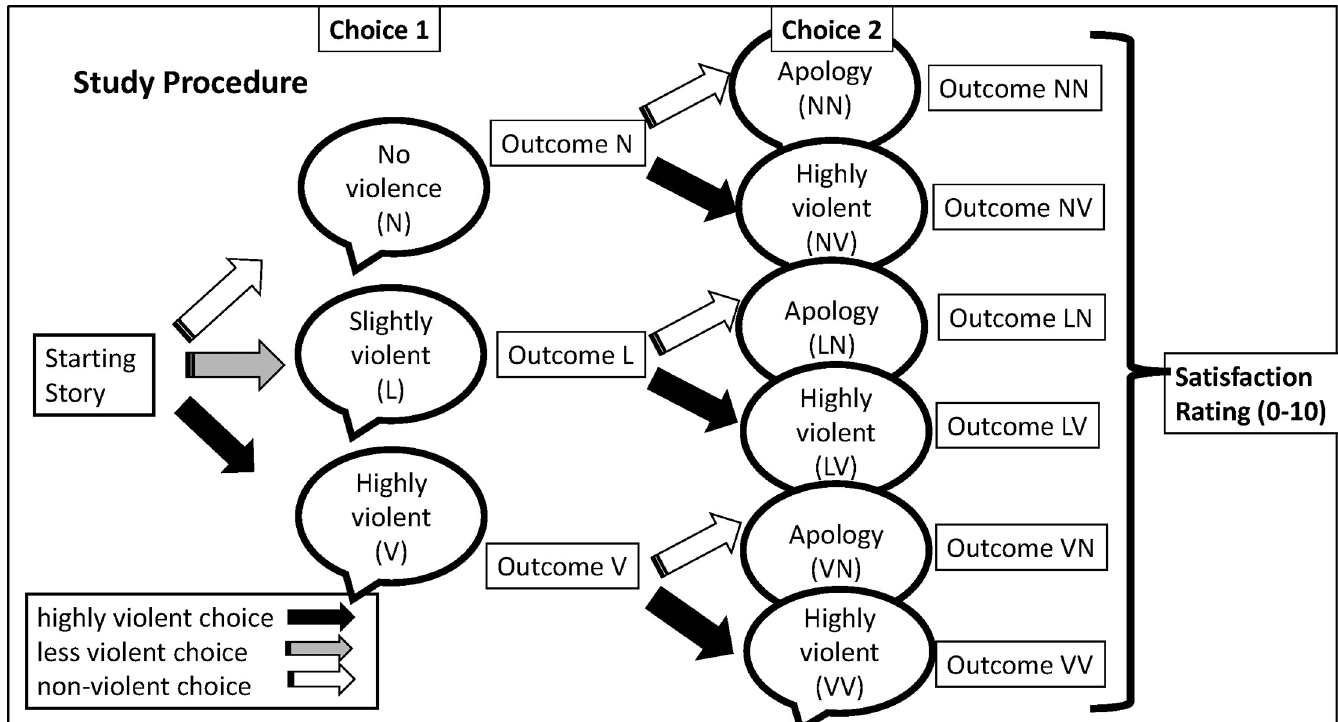
Fig 1. Presented is the order of the tasks for the participants, beginning with making choice 1, choice 2 to providing a satisfaction rating.